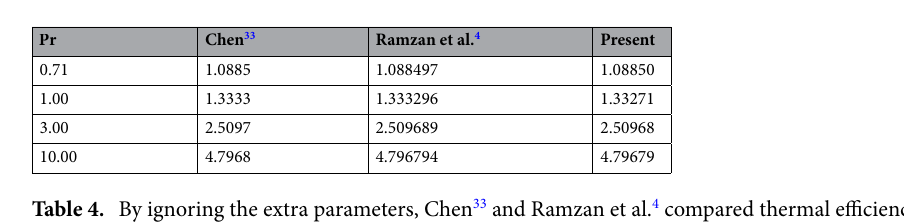
Table 4. By ignoring the extra parameters, Chen 33 and Ramzan et al. 4 compared thermal efficiency for different amplitudes of Prandtl number ( Pr ).